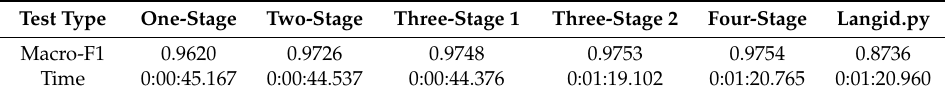
Table 27. Comparative results of the effect of noisy content on LI.